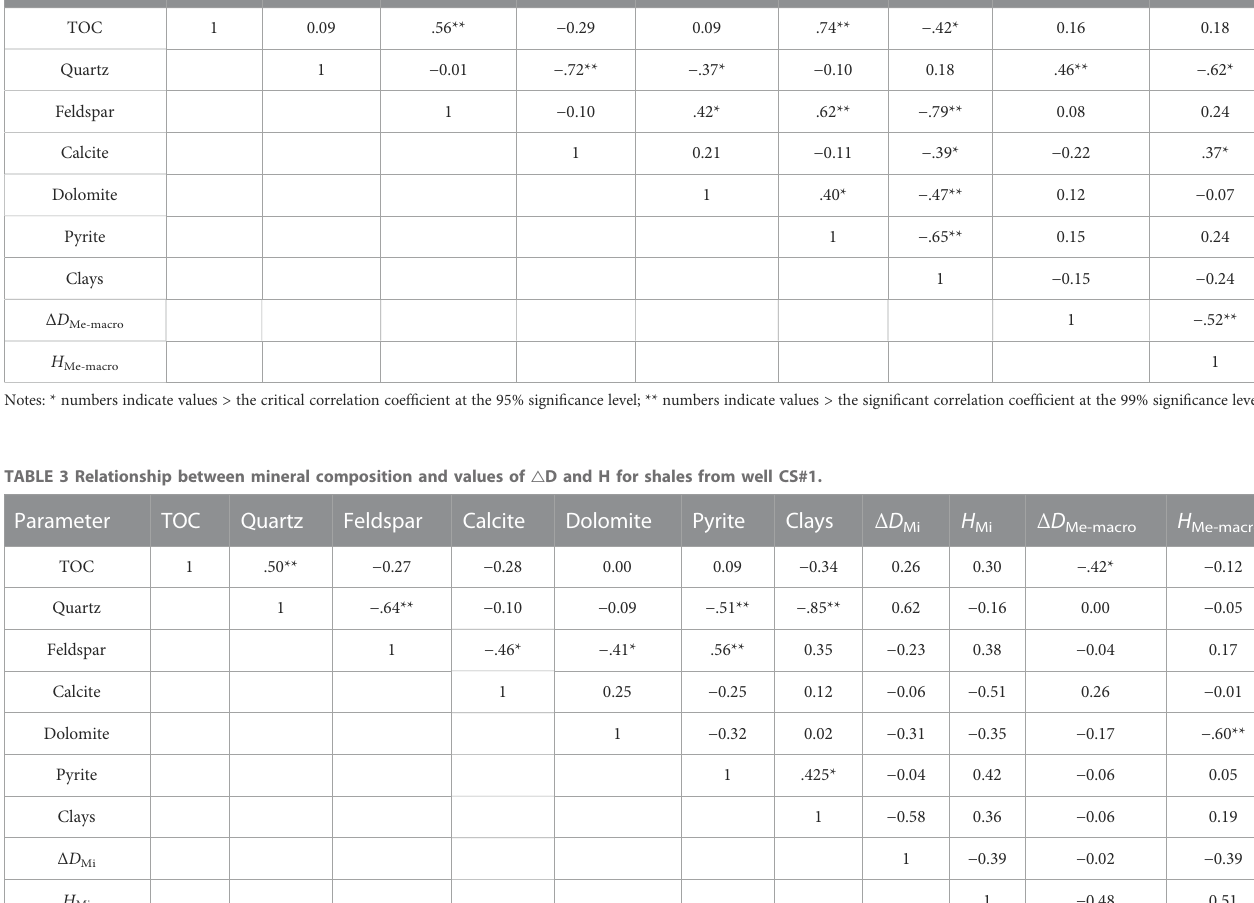
TABLE 2 Relationship between mineral composition and values of △ D and H for shales from well MS#1. Parameter